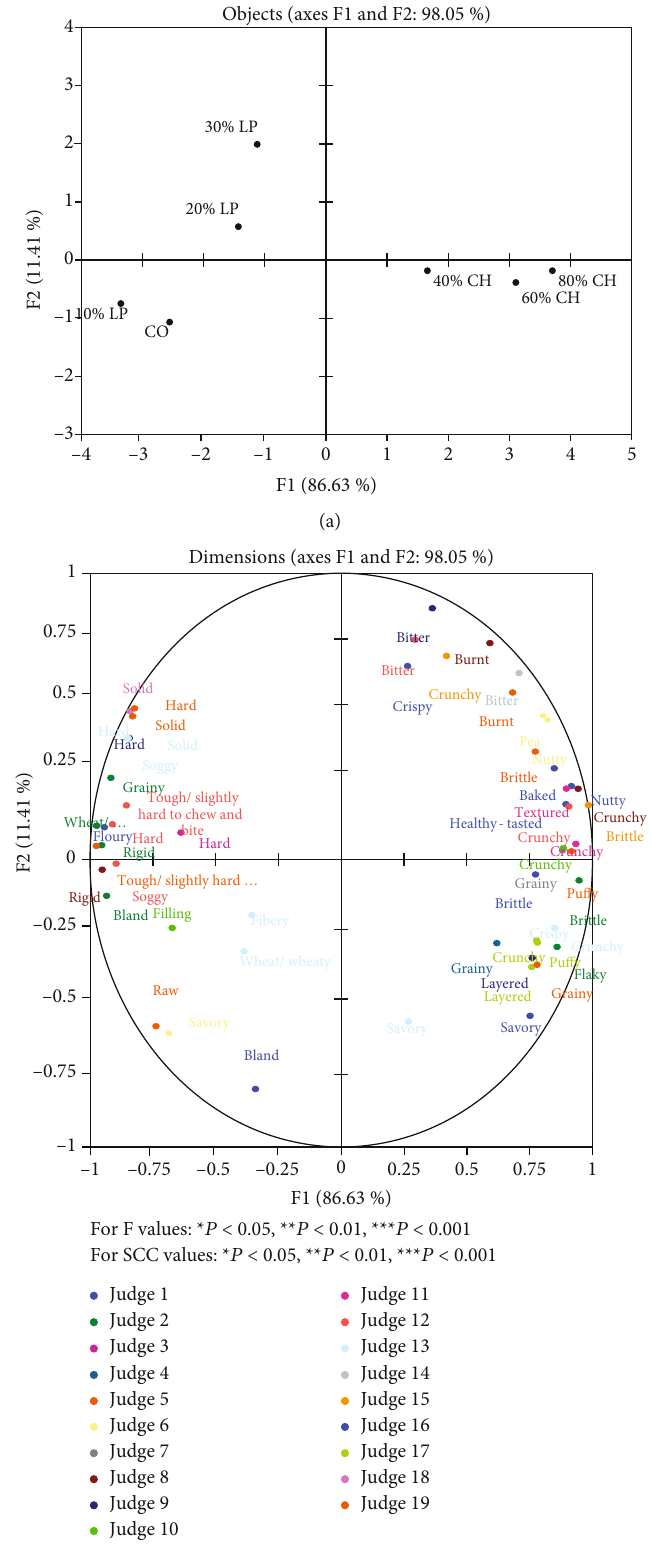
Figure 2: Generalized Procrustes Analysis (GPA) of Indonesian judge ’ s evaluations of seven crackers samples via Flash pro fi le analysis (a) and variable plot (b). Only attributes generated by judges with good repeatability and ability of discrimination were included. For F values: ∗ P < 0 : 05 , ∗∗ P < 0 : 01 , ∗∗∗ P < 0 : 001 . For SCC values: ∗ P < 0 : 05 , ∗∗ P < 0 : 01 , ∗∗∗ P < 0 : 001